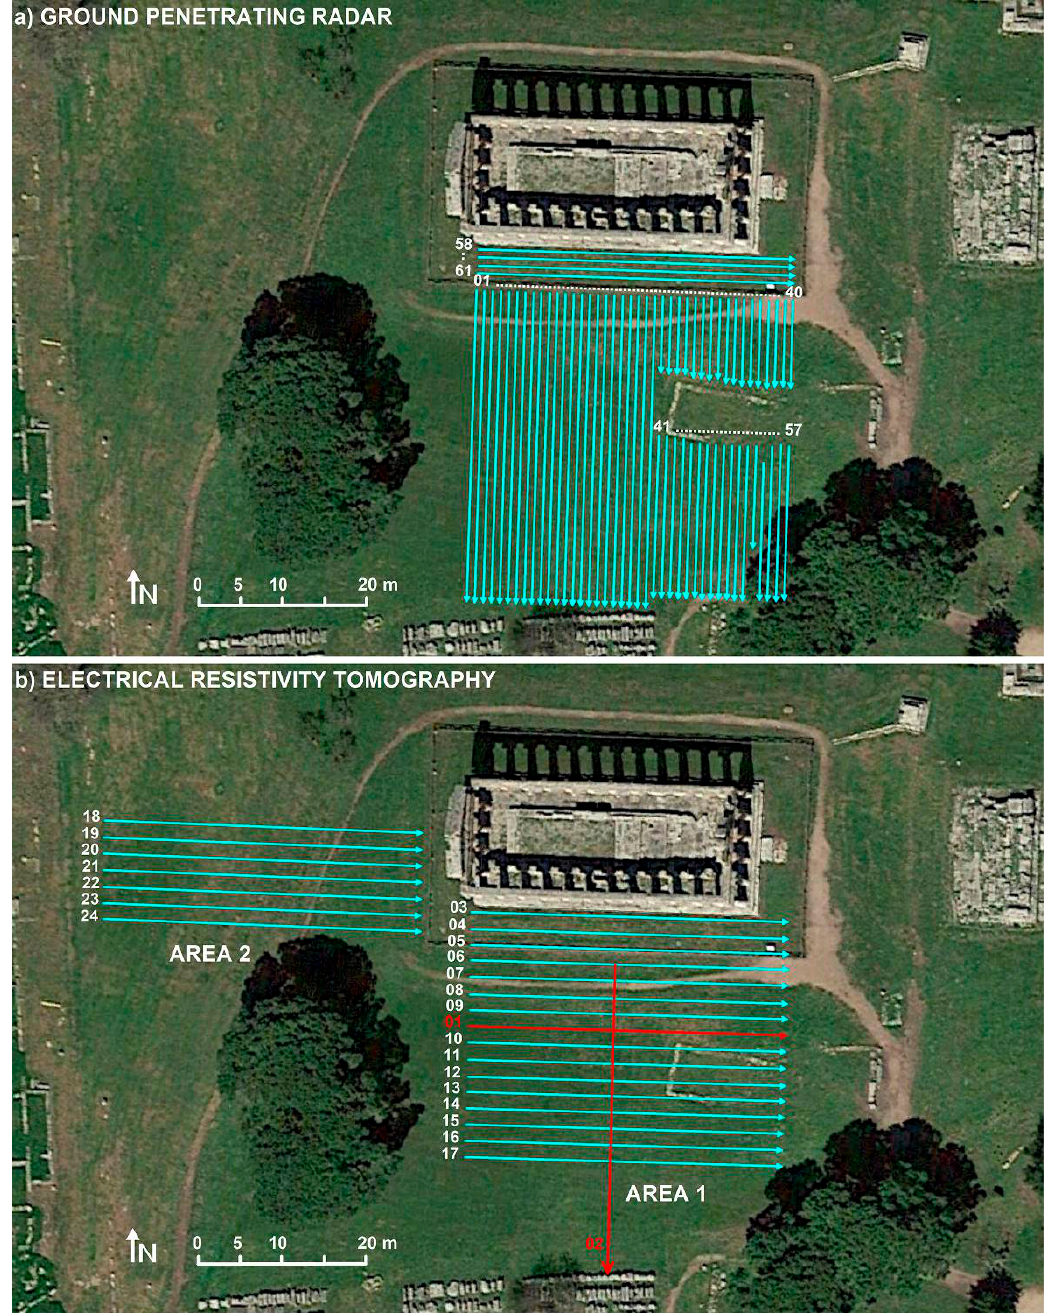
Figure 4. The location of the ground penetrating radar (GPR) ( a ) and electrical resistivity tomography (ERT) surveys ( b ).